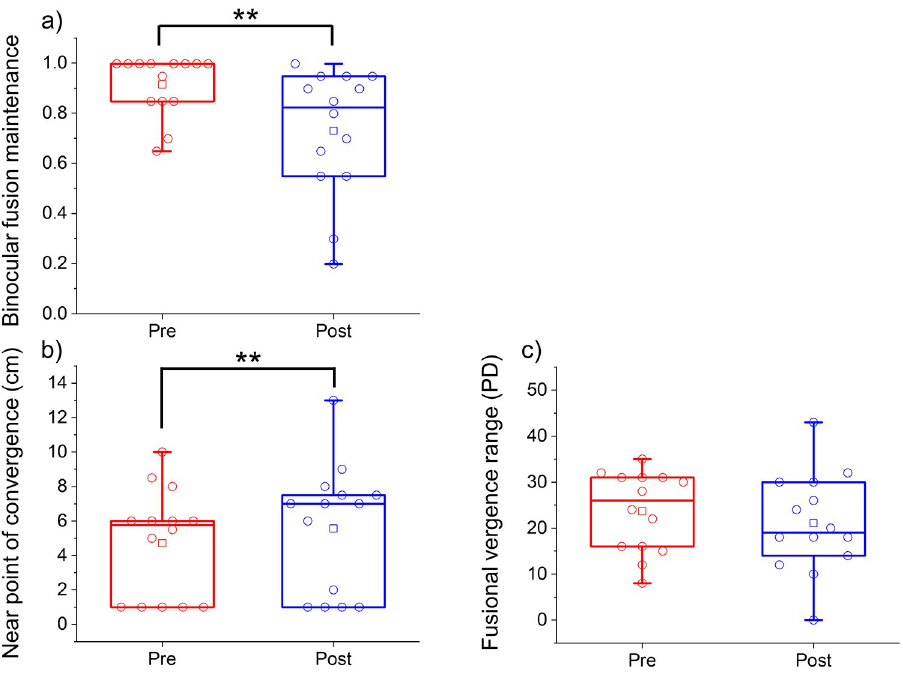
Fig 3. Binocular fusion maintenance (BFM) (a), near point of convergence (NPC) (b), and fusional vergence range (c) before (red) and after (blue) the visual task within the intermittent exotropia (IXT) group. The red and blue circles indicate individual BFM, NPC, and fusional vergence range values within the IXT group. The red and blue squares indicate the mean values for all the patients. �� P < 0.01, Wilcoxon signed-rank test.